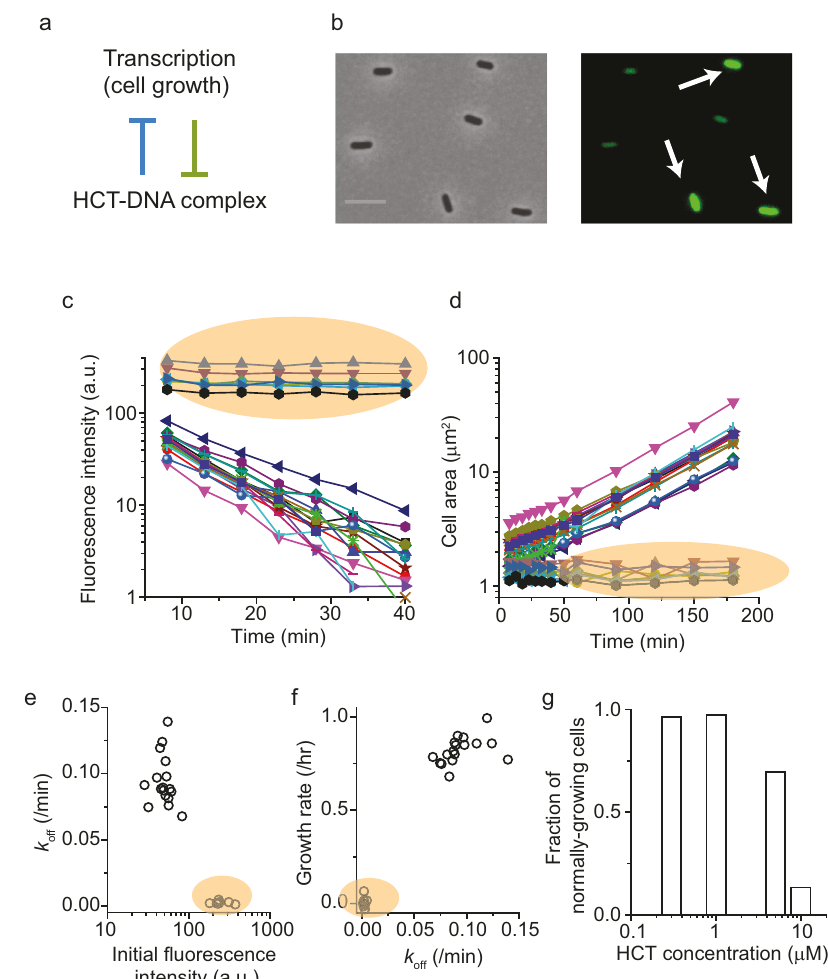
Fig. 3 Heterogeneous inhibitory activities of HCT at single-cell resolution. a Formation of HCT-DNA complex represses transcription, while transcription represses the complex formation by stimulating unbinding. b Cells were pre-incubated with 5 μ M HCT and imaged with a microscope at single-cell resolution. We found two distinct levels of intracellular HCT intensity, indicating that its accumulation on the target (DNA) is heterogeneous across a cell population. Note that HCT emits blue fl uorescence but is depicted as green here for the clarity of the images. The scale bar represents 5 μ m. c , d Cells pre- incubated with 5 μ M HCT were transferred to HCT-free media (which de fi nes time zero), and intracellular HCT intensity and cell area were observed over time using a microscope. Cells exhibiting high HCT intensity (orange shades) exhibited no HCT unbinding and no growth. On the other hand, cells with initially weak HCT intensity exhibited rapid HCT unbinding and active cell growth. e , f Data plotted in c , d were quantitatively analyzed. g The fraction of the subpopulation with rapid HCT unbinding and active cell growth decreases at higher external HCT concentrations. The plotted data were from a single experiment. A biological replicate was conducted to con fi rm the